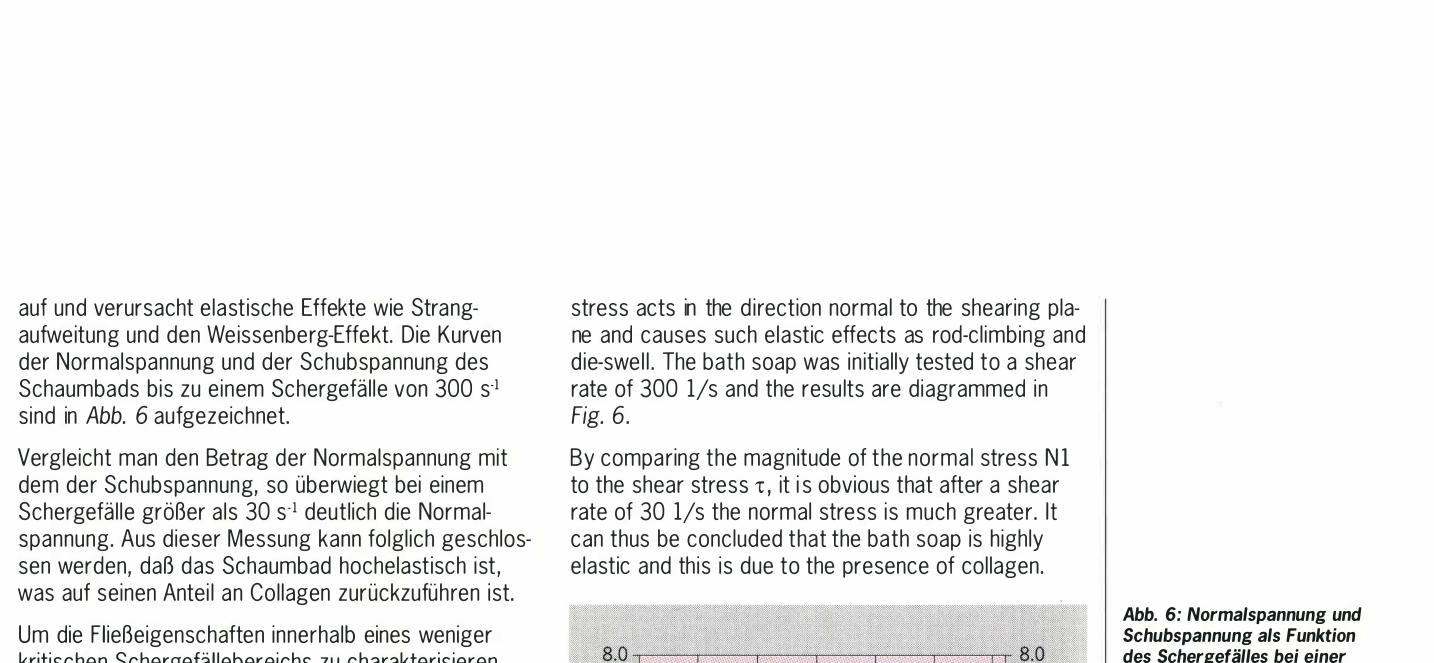
Fig. 6: Normal stress and shear stress as a function of shear rate for the bath soap